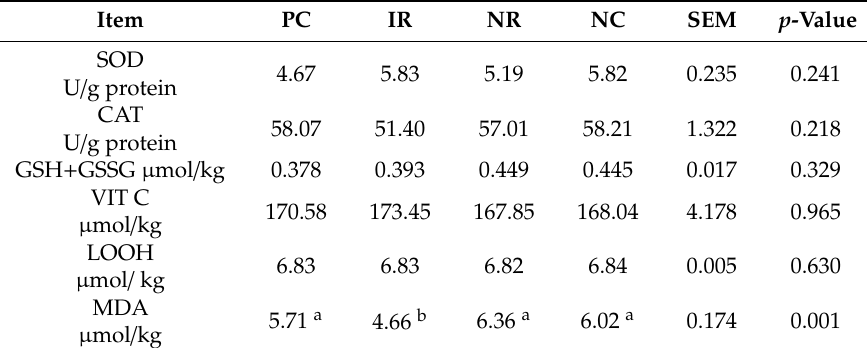
Table 9. Indicators of redox status in the liver of